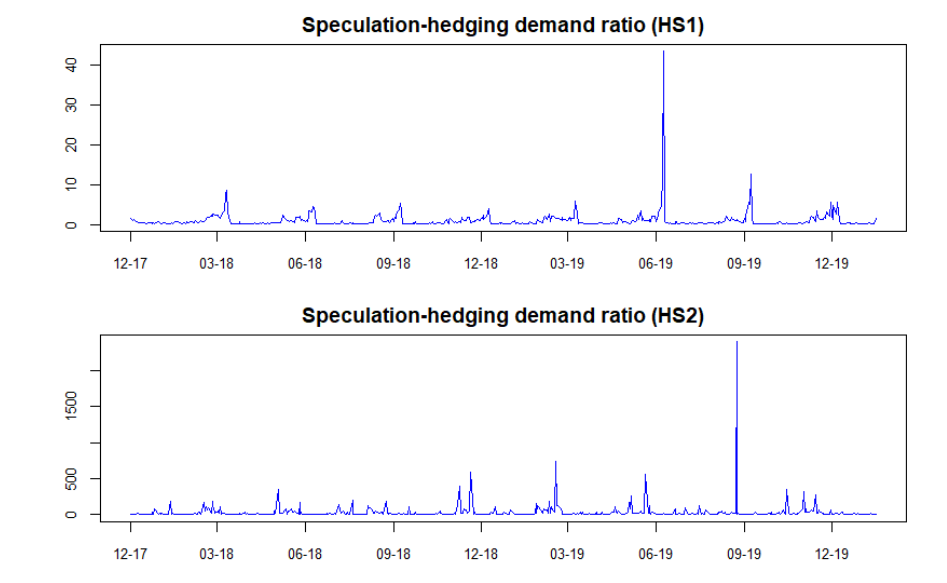
Figure 2. Speculation-hedging ratios for Bitcoin futures